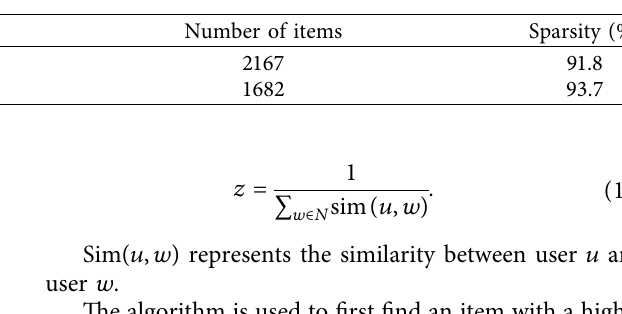
Table 5: Dataset related information.